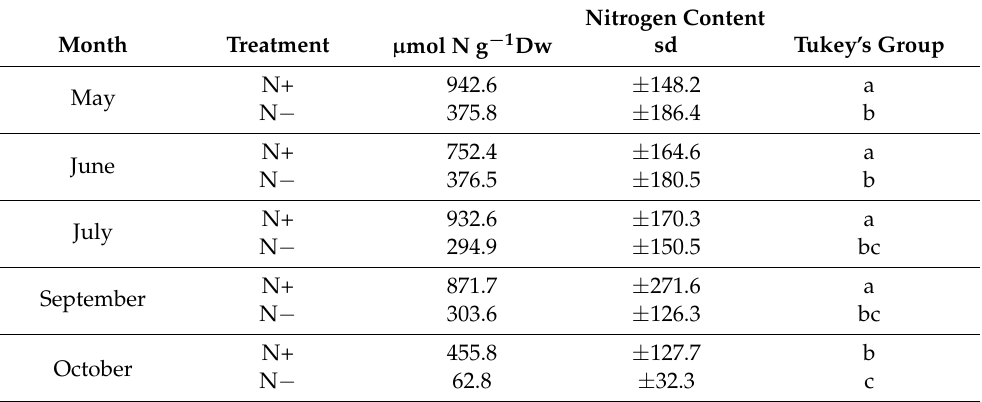
Table 2. Nitrogen content of mature leaves removed from the plant according to grower’s practice (deleafing). Data on an average of 5 leaves per month per treatment. sd stands for the standard deviation. Letters indicate results of statistical analysis according to Tukey’s test: different letters indicate statistical